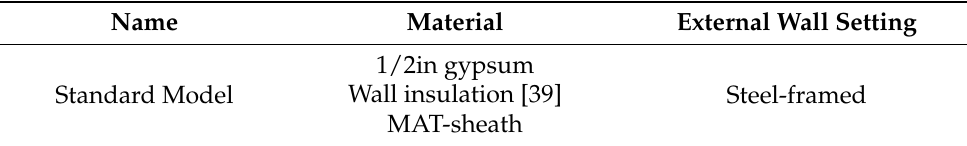
Table A1. Standard model construction settings.